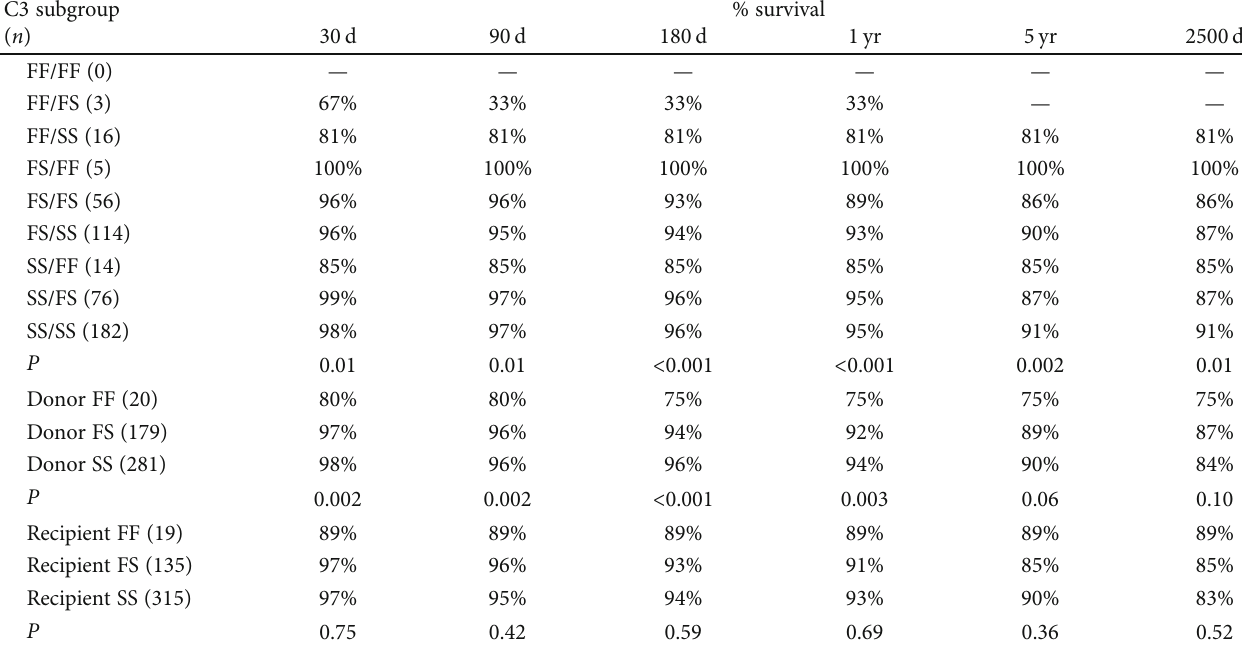
Table 2: Life tables for patient survival. Patient survival life table up to 2500 days posttransplantation in liver graft donors and recipients classi fi ed according to C3 genotype or presence of C3F allele.